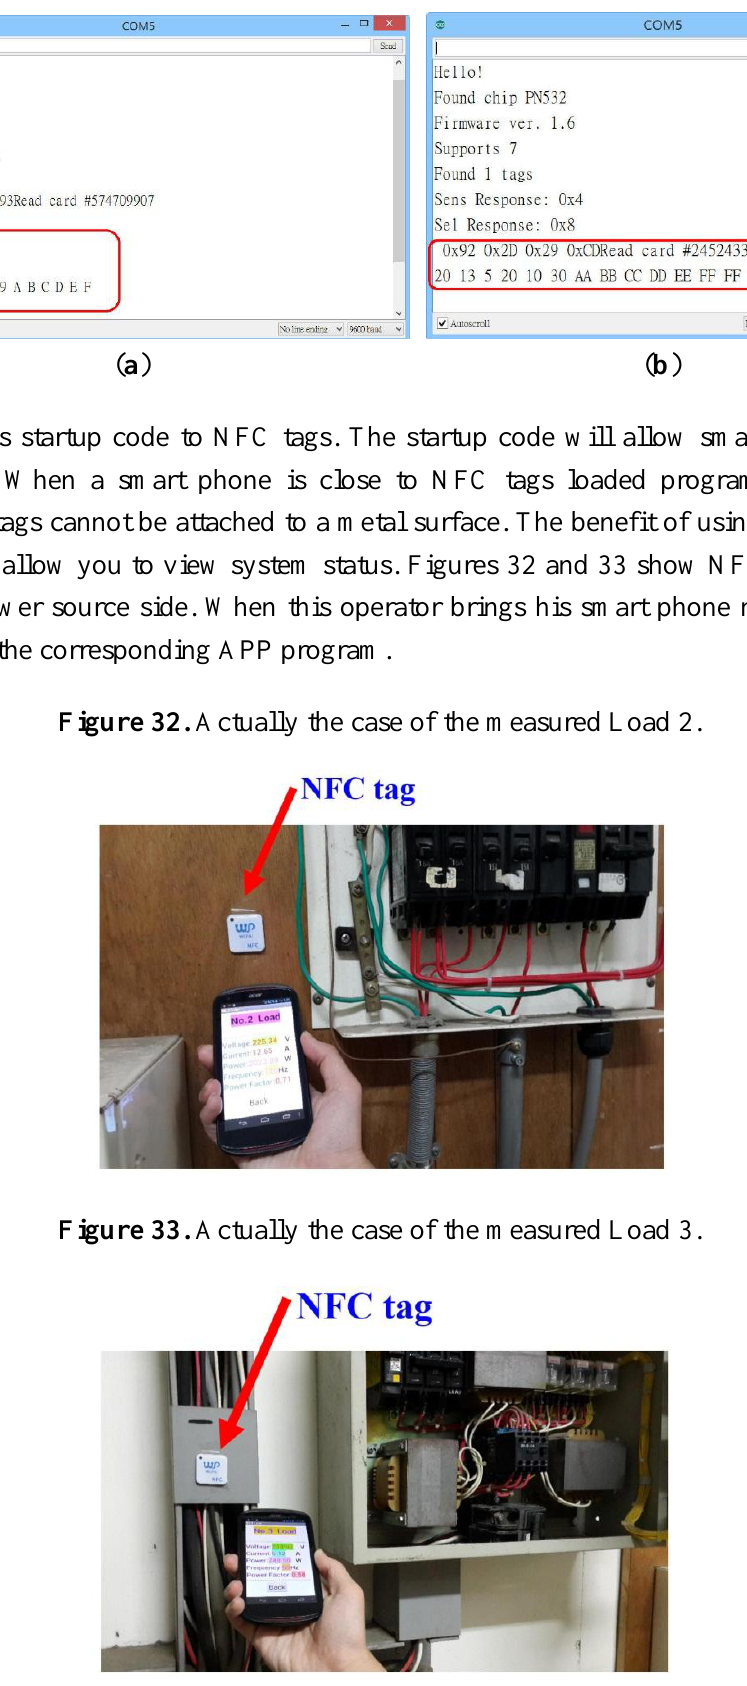
Figure 31. Writing different data to a NFC tag. ( a ) Writing 16 hex data to NFC tag; ( b ) Writing 2013/05/20 data to NFC tag.